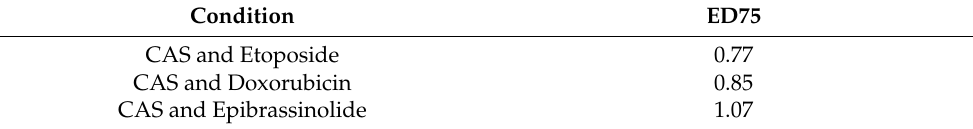
Table 2. Combination index (CI) for castasterone (CAS), epibrassinolide (EB), and chemotherapy drugs.